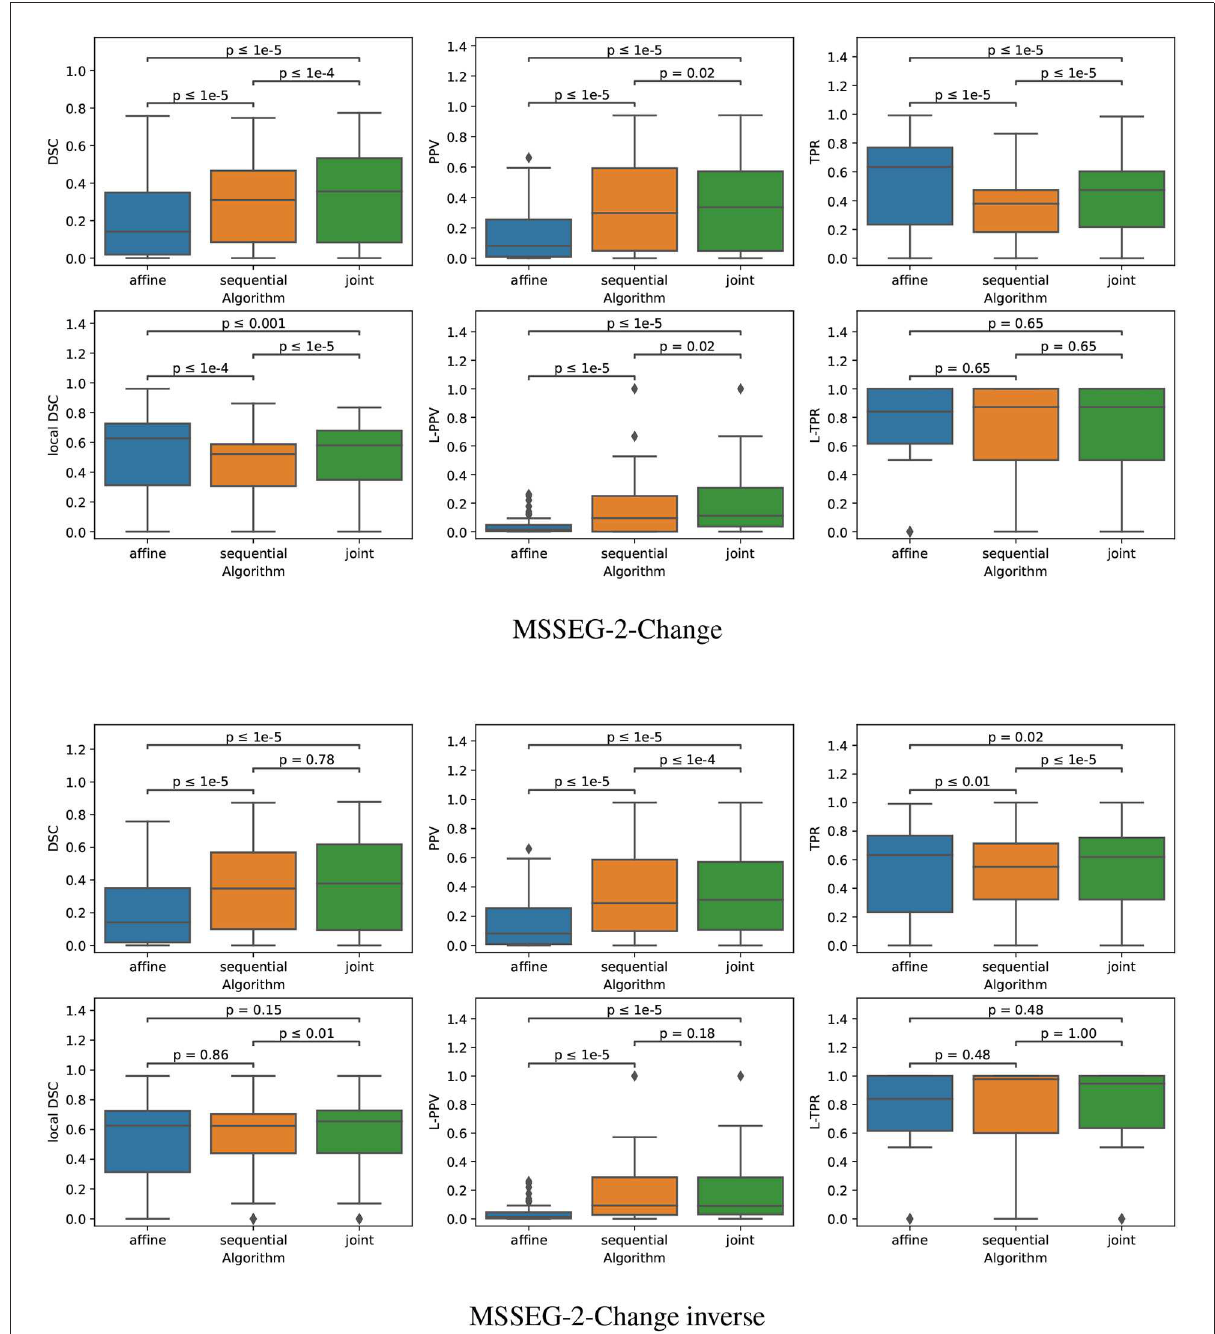
FIGURE9 Boxplots corresponding to the results summarized in Table 3 for both MSSEG-2-Change and MSSEG-2-Change inverse ( N Subject = 61). Statistical significancy is evaluated thanks to the Wilcoxon signed-rank test between each pair of methods while applying Benjamini/Hochberg FDR